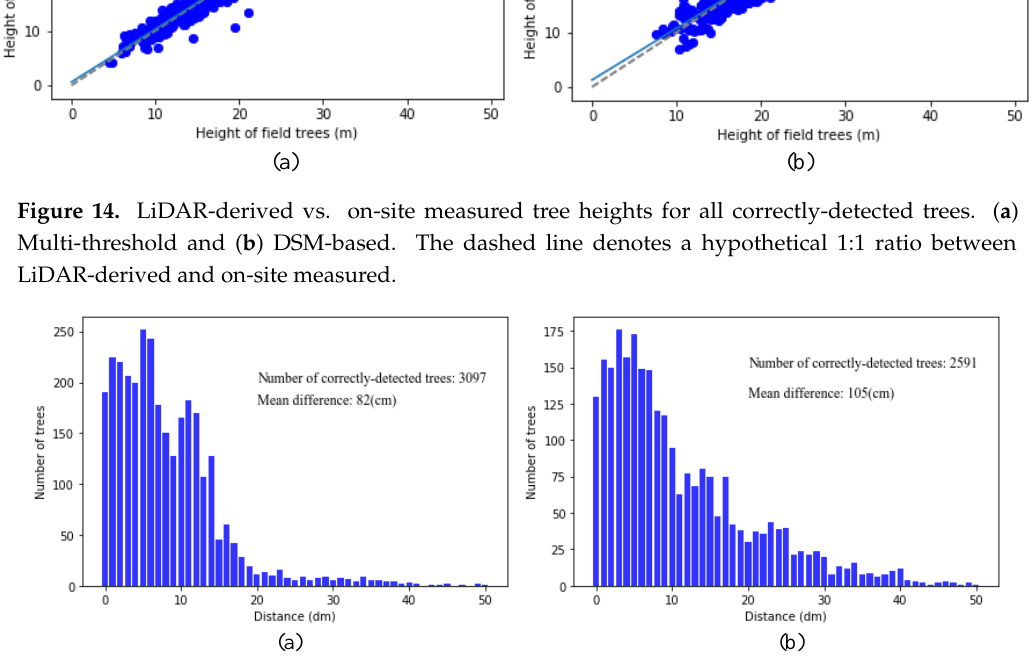
Figure 14. LiDAR-derived vs. on-site measured tree heights for all correctly-detected trees. ( a ) Multi- threshold and ( b ) DSM-based. The dashed line denotes a hypothetical 1:1 ratio between LiDAR- derived and on-site measured.